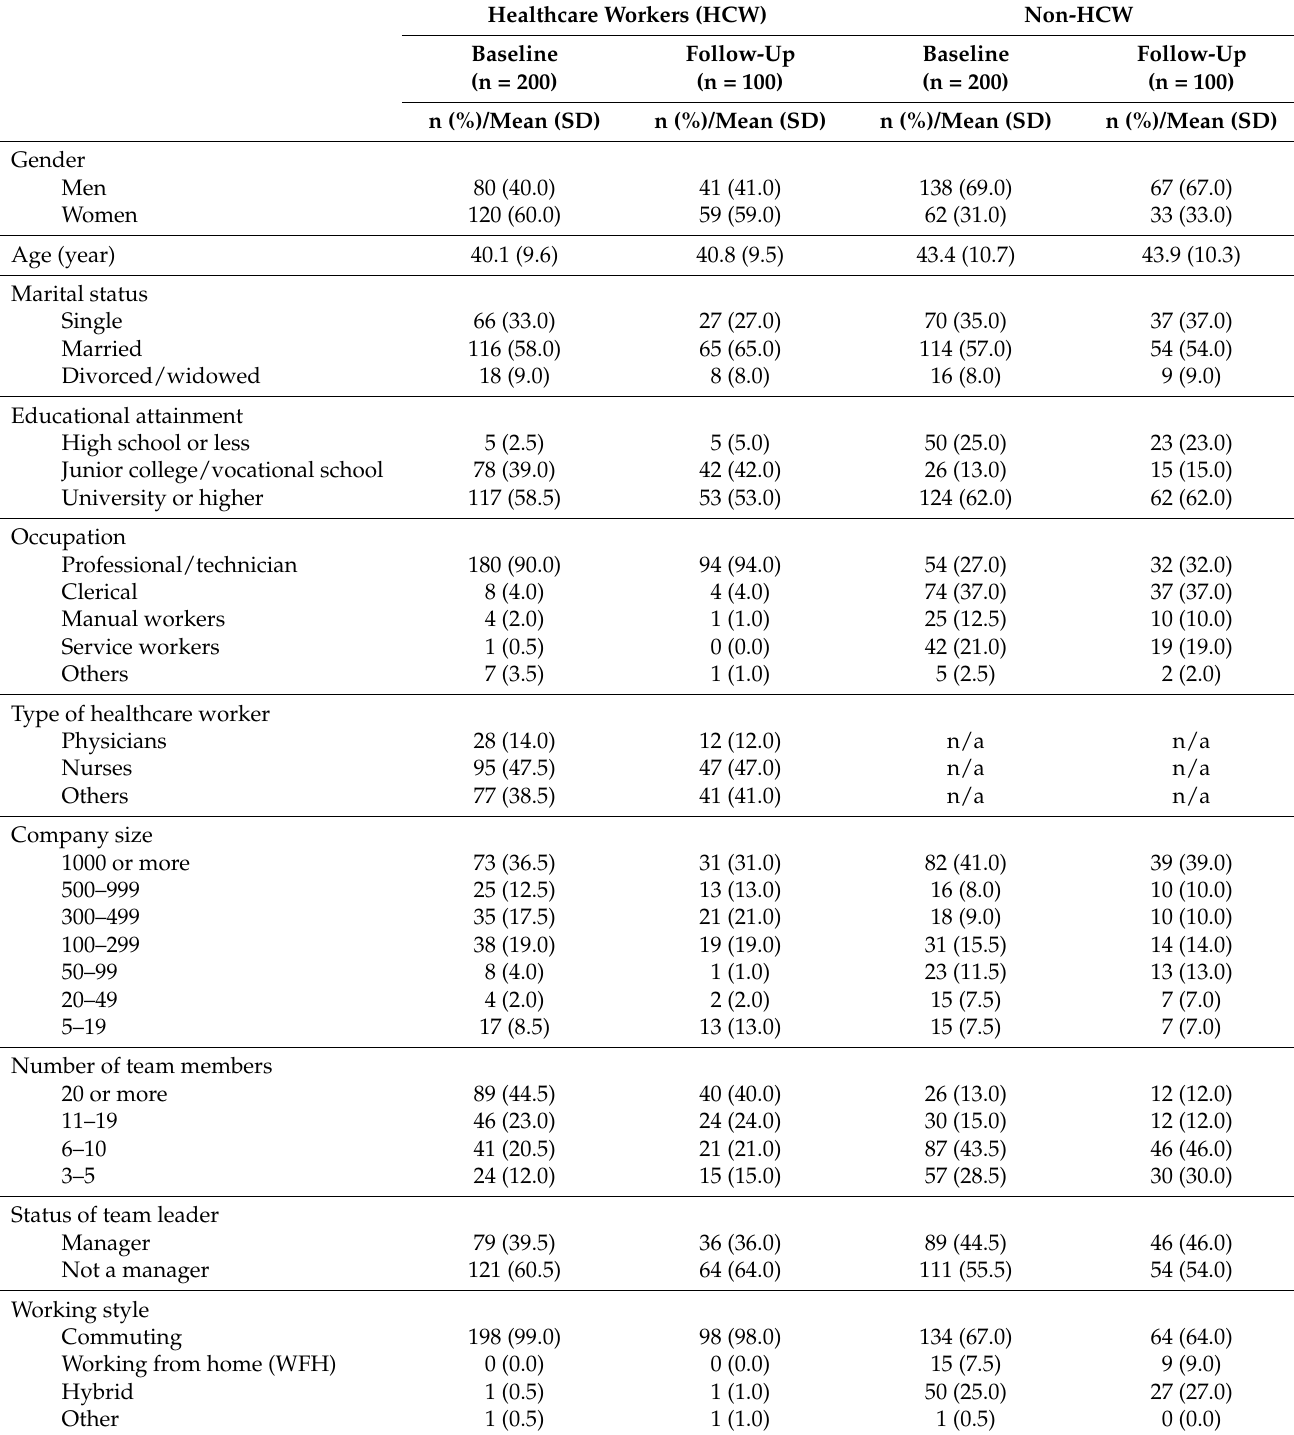
Table 1. Characteristics of Japanese non-manager employees with more than three team